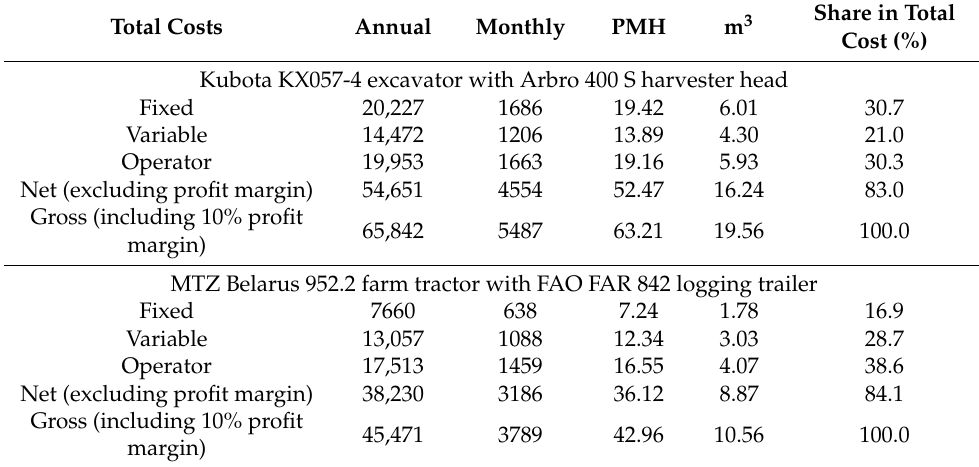
Table 9. Cost calculations in euros.